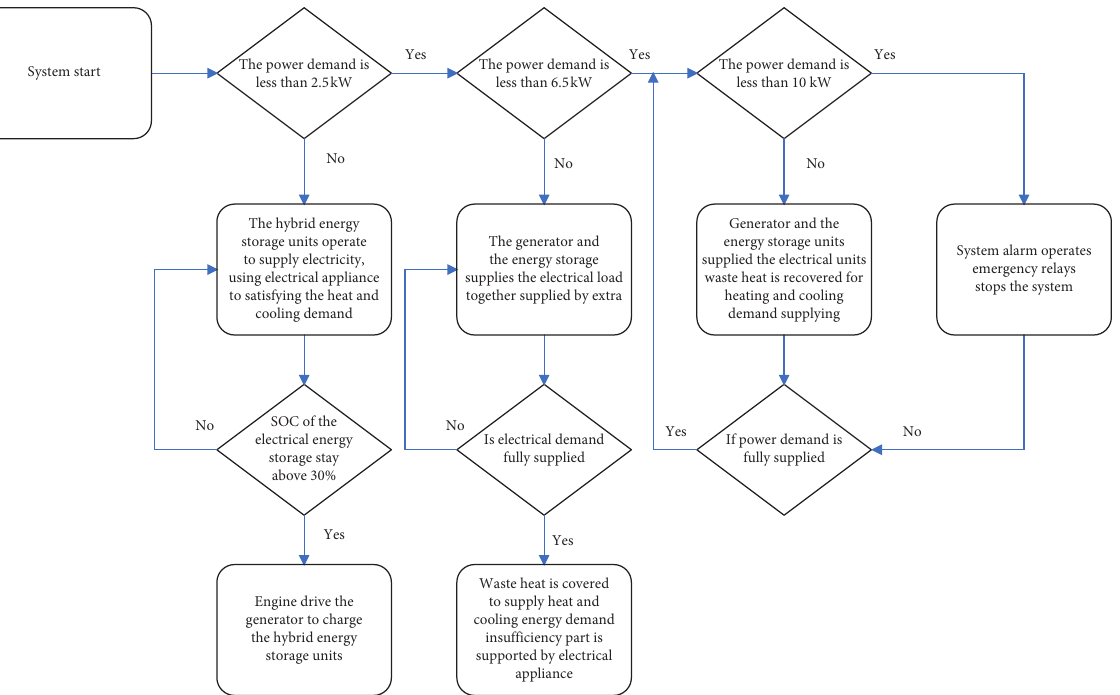
Figure 2: Control strategy of the